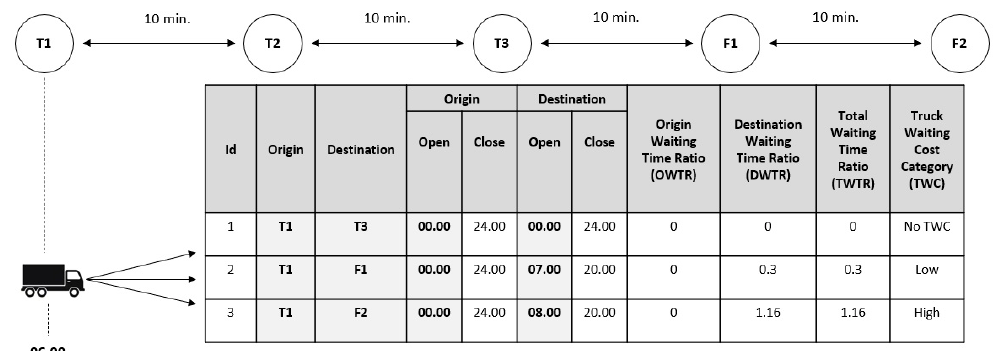
Figure 6. Waiting time ratio (WTR) and truck waiting cost (TWC).